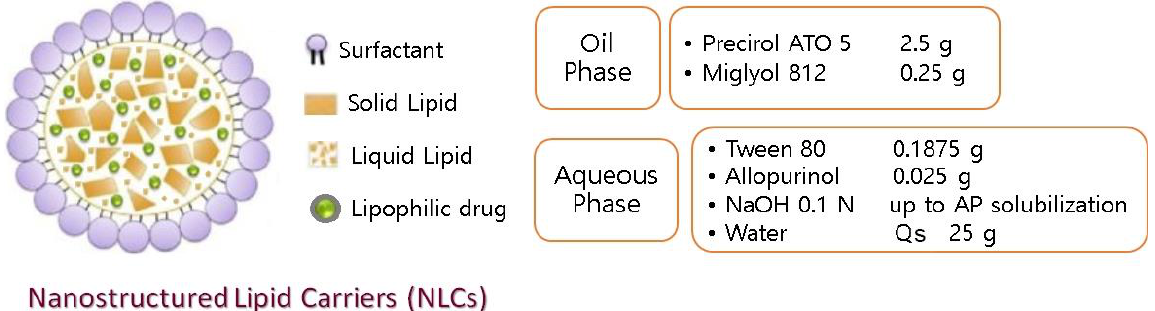
Figure 1. On the left: schematic representation of an individual lipid nanoparticle showing the spatial distribution of the components. On the right: AP-NLC qualitative and quantitative composition. Solid lipid: Precirol ATO 5; liquid lipid: Miglyol 812.